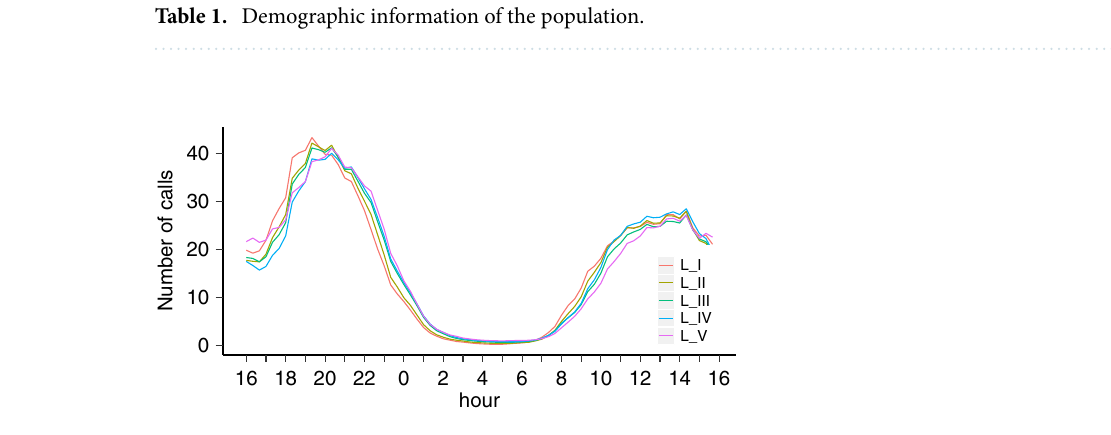
Figure 1. Aggregated individual calling activity for weekdays in 5 geographical regions. For each the 5 longitudinal bands L I – L V , the calling activity of the analyzed individuals for all 24-h over-the-night periods during weekdays (Mondays to Thursdays) aggregated over the 3 year period. The activity in the easternmost band L I (red line) is noticeably shifted towards early hours compared to the activity in the westernmost band L V (magenta line). The bands limits are as follows: L I L